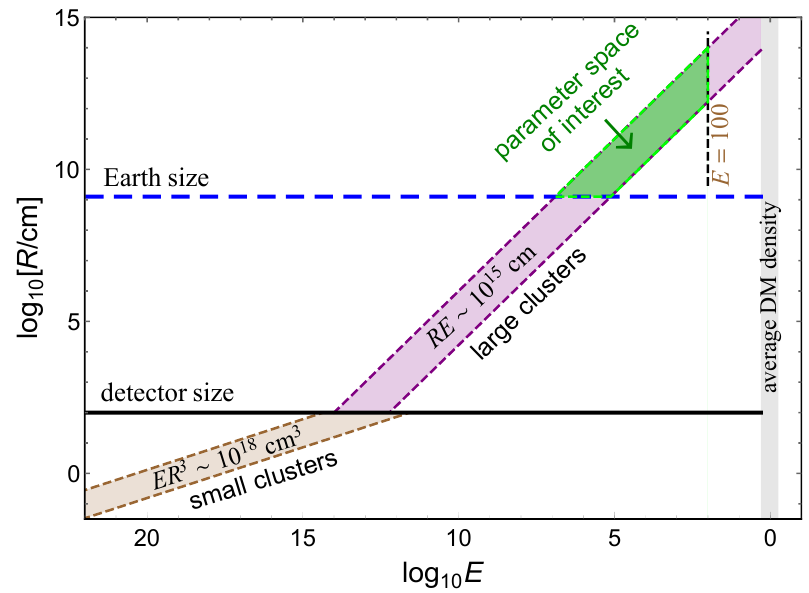
Figure 2 . The critical region for small clusters de(cid:12)ned by ER 3 ’ 10 18 (cid:6) 1 cm 3 is indicated by the brown diagonal strip in the left-lower part of the (cid:12)gure. The critical region for large clusters de(cid:12)ned by ER ’ 10 15 (cid:6) 1 cm is indicated by the purple diagonal strip in the right-upper part of the (cid:12)gure. The signi(cid:12)cance of the shaded areas is | as explained in the text | that for clusters with R